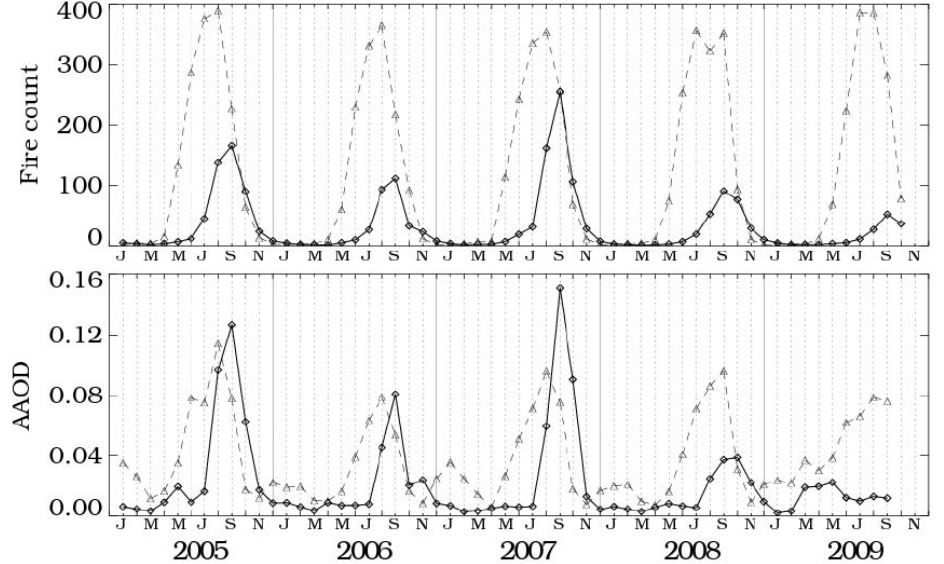
Fig. 4. Five year record of monthly average values of fire counts (top), and 388nm aerosol absorption optical depth (bottom) for the SA (solid line) and CA (dashed line)